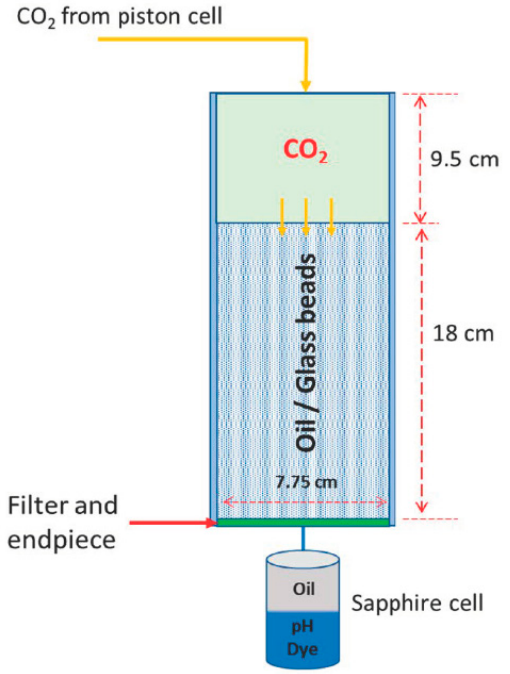
Figure 3. Simplified sketch of the main experimental setup with steel cell and porous media and sapphire cell for detection of CO 2 breakthrough at bottom.